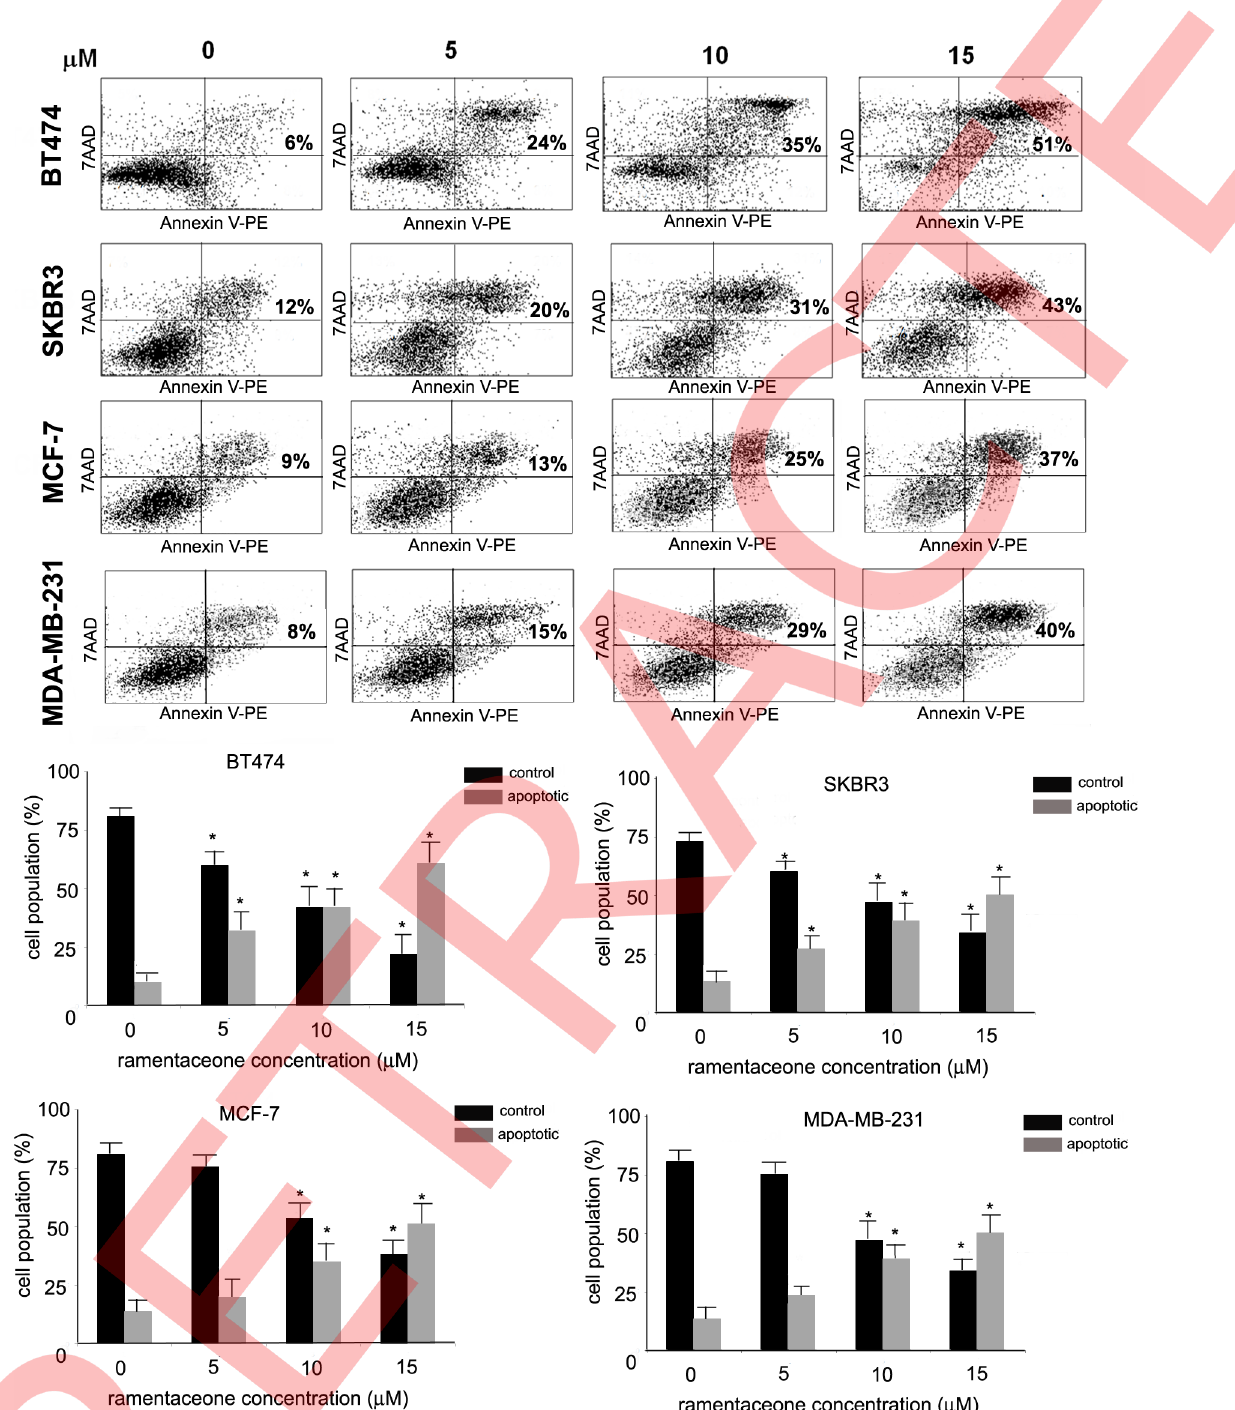
Fig 5. Induction of apoptosis by ramentaceone in breast cancer cells. Apoptotic changes in plasma membrane induced by ramentaceone. Cells were treated with ramentaceone (0 – 15 μ M) for 24 h, stained with Annexin V-PE/7-AAD, and analyzed by flow cytometry. Values represent mean ± SD of three independent experiments. p < 0.05 ( * ) indicates differences between control and ramentaceone-treated